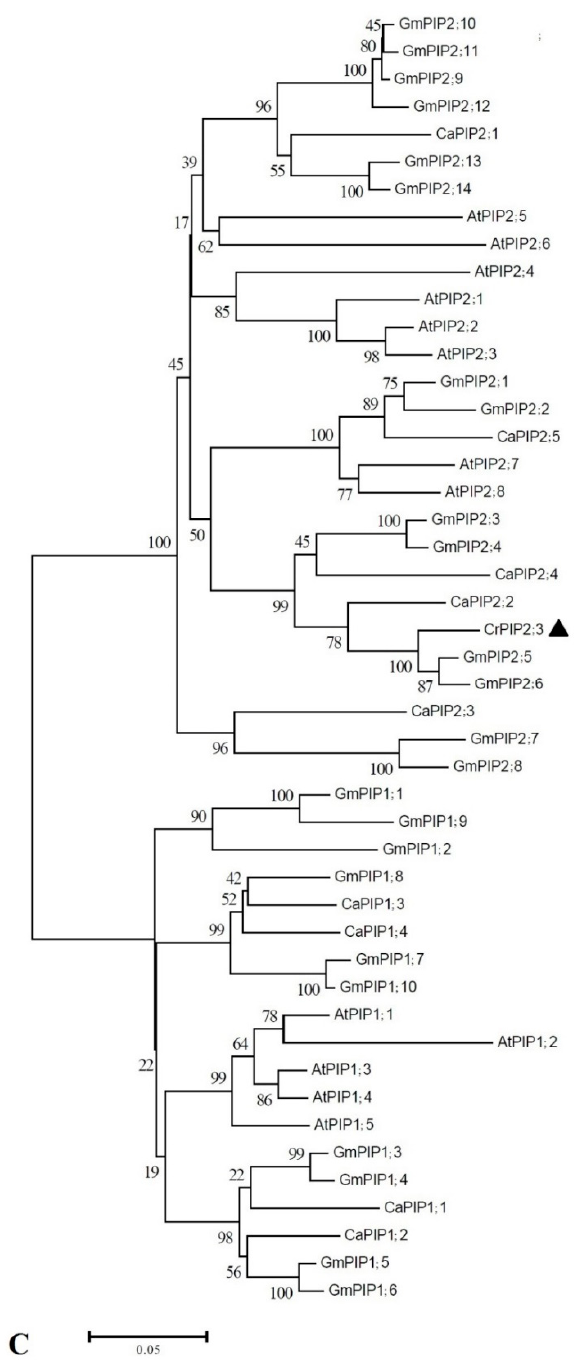
Figure 1. Protein sequence, transmembrane domain prediction, and phylogenetic analyses of the CrPIP2;3 protein. ( A ) Sequence alignment analysis of CrPIP2;3 with other known PIP proteins. The conserved amino acid residues in all proteins are highlighted in black and gray. The MIP domain (PF00230) is marked with a green frame. Six transmembrane helices domains (TM1–TM6) and two conserved Asn–Pro–Ala (“NPA”) motifs (LB and LE) are marked with black and red solid lines. The aromatic/arginine (ar/R) selectivity filters (H2, H5, LE1, and LE2) and Froger’s positions (FPs) (P1, P2, P3, P4, and P5) are marked with blue, brown, and green solid lines, respectively. The MIP signal sequence between TM2 and TM3 is also lined in a gray color. ( B ) Predicted 3D structure of CrPIP2;3 generated using the Phyre2 server. ( C ) The phylogenic tree of CrPIP2;3 and other PIP proteins from A. thaliana and soybean. The black triangle symbol showed the position of CrPIP2;3.